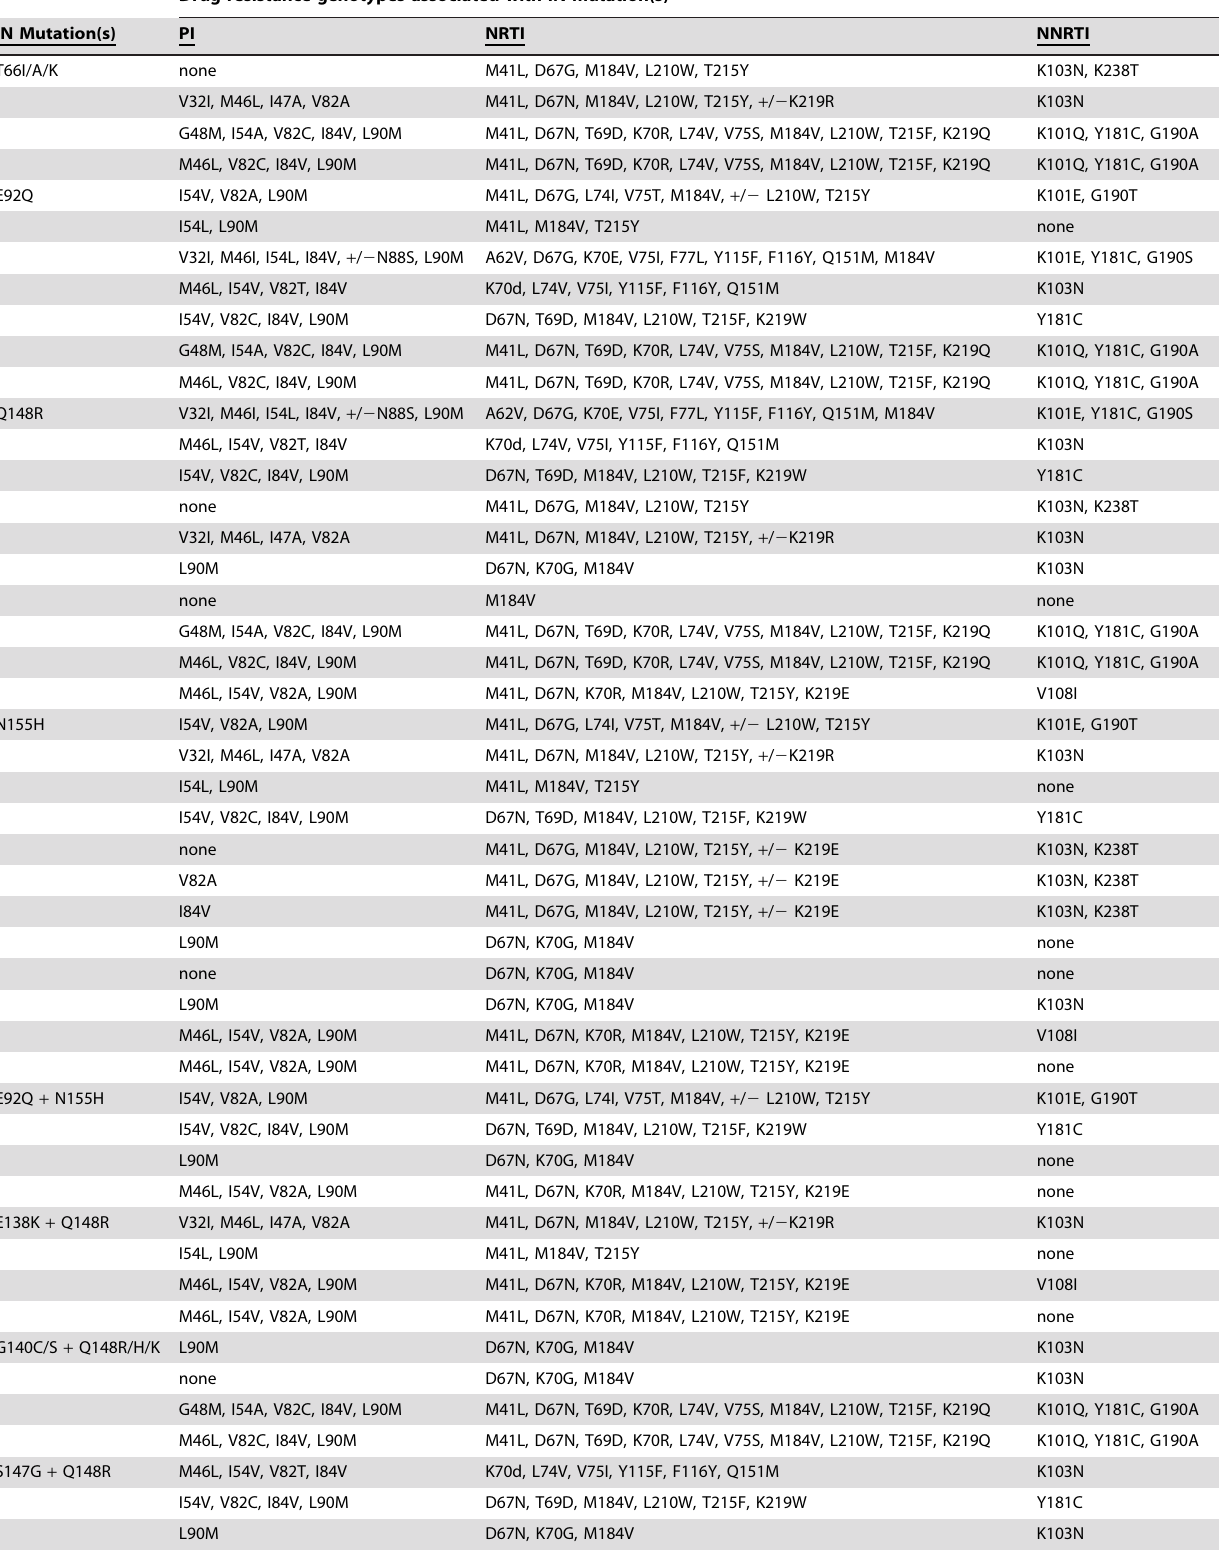
Table 1. Linkage of the 8 most common INI DRM patterns to PR/RT DRM.